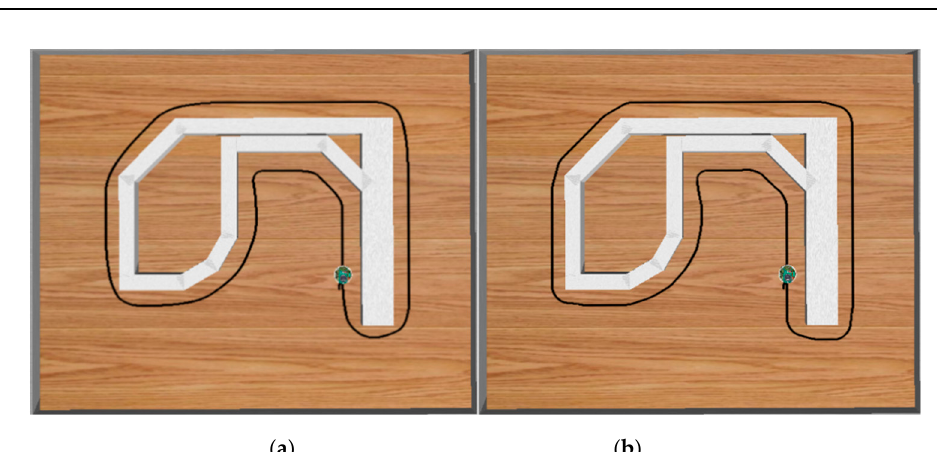
( a ) ( b ) Figure 17. Moving path of the robot in the testing environment 1: ( a ) DGDE-1 and ( b ) DGDE-2. ( a ) ( b ) Figure 18. Moving path of the robot in the testing environment 2: ( a ) DGDE-1 and ( b ) DGDE-2. 4. Cooperative Carrying and Navigation Control of Multi-Evolutionary Mobile Robots In this section, the cooperative carrying and navigation control of multi-evolutionary mobile robots is discussed. Figure 19 shows that the distance between two robots 𝑅 (cid:3031) was set to 15 cm and a rectangular object was placed on the two robots. The front and rear robots represent the leader and follower, respectively. In the experiments, the leader explored the front environment, and the follower assisted the leader in lifting objects to achieve obstacle avoidance and prevent objects being dropped during cooperative carrying.